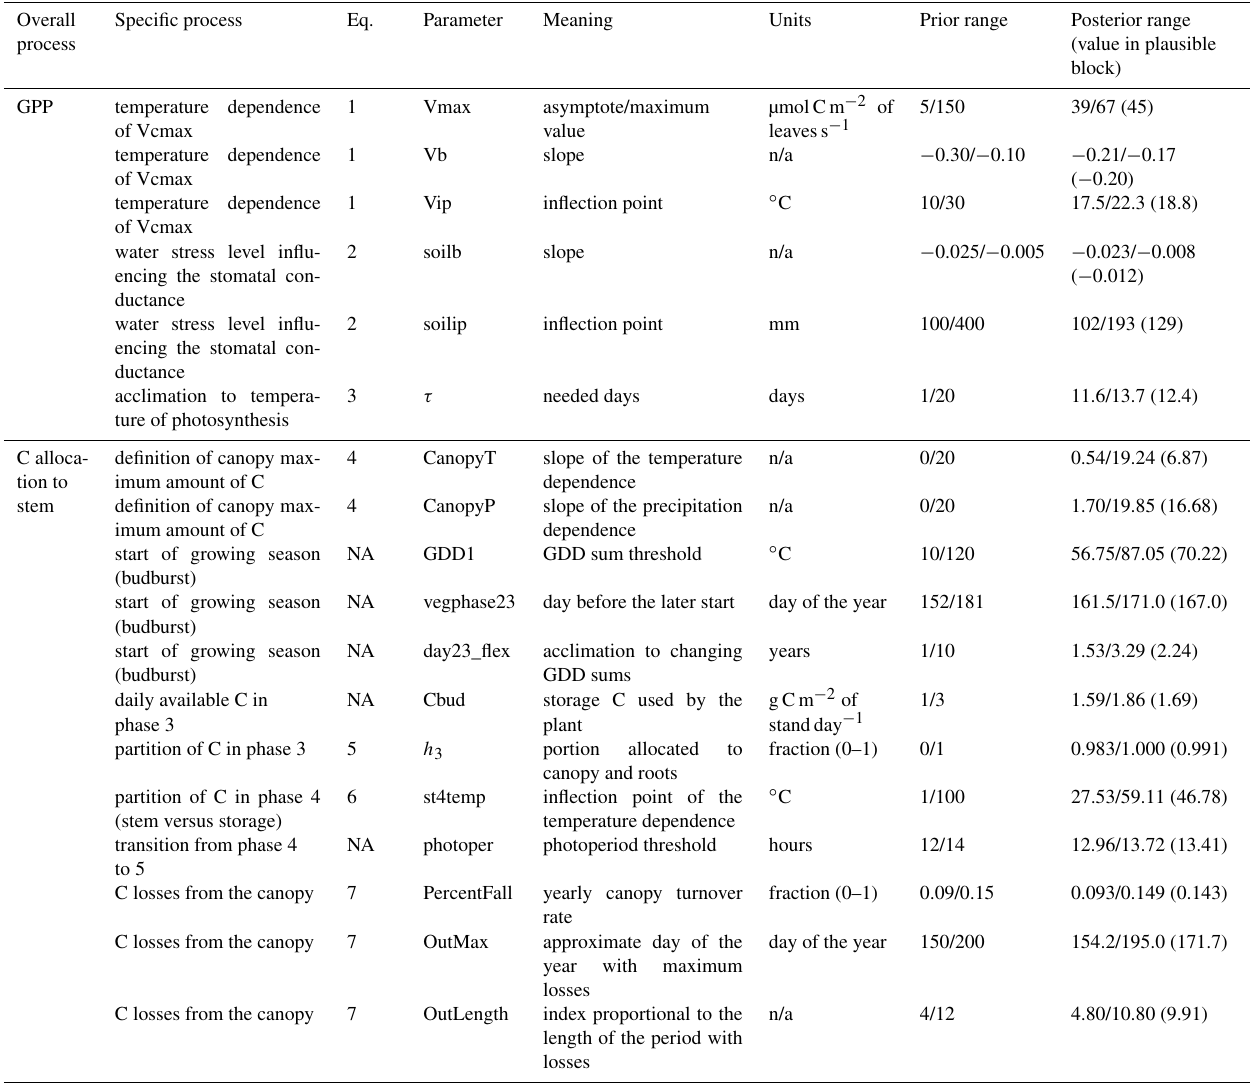
Table 1. Definitions, symbols and prior and posterior ranges of calibrated parameters. Small posterior ranges relative to the prior ones indicate sensitive